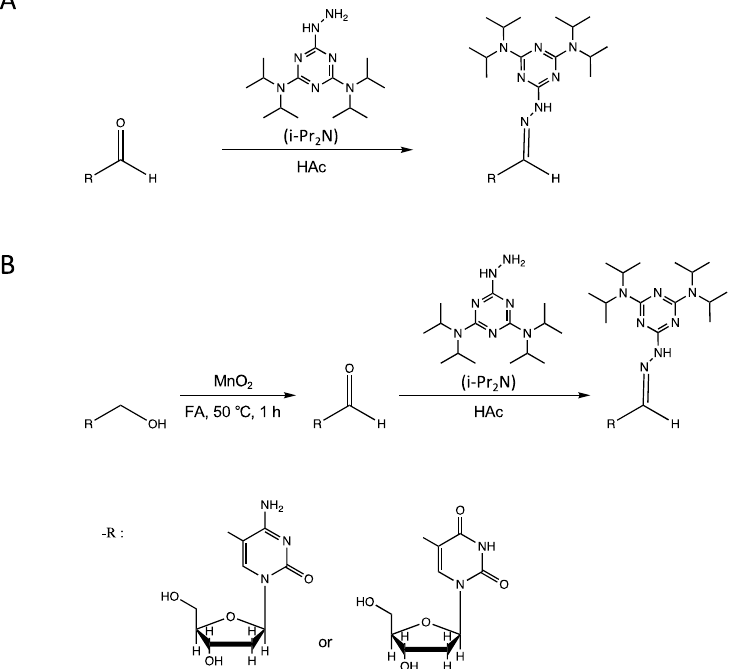
Figure 1. The strategy of chemical labeling of ( A ) 5fdC and 5fdU and ( B ) 5hmdC and 5hmdU with i-Pr 2 N.